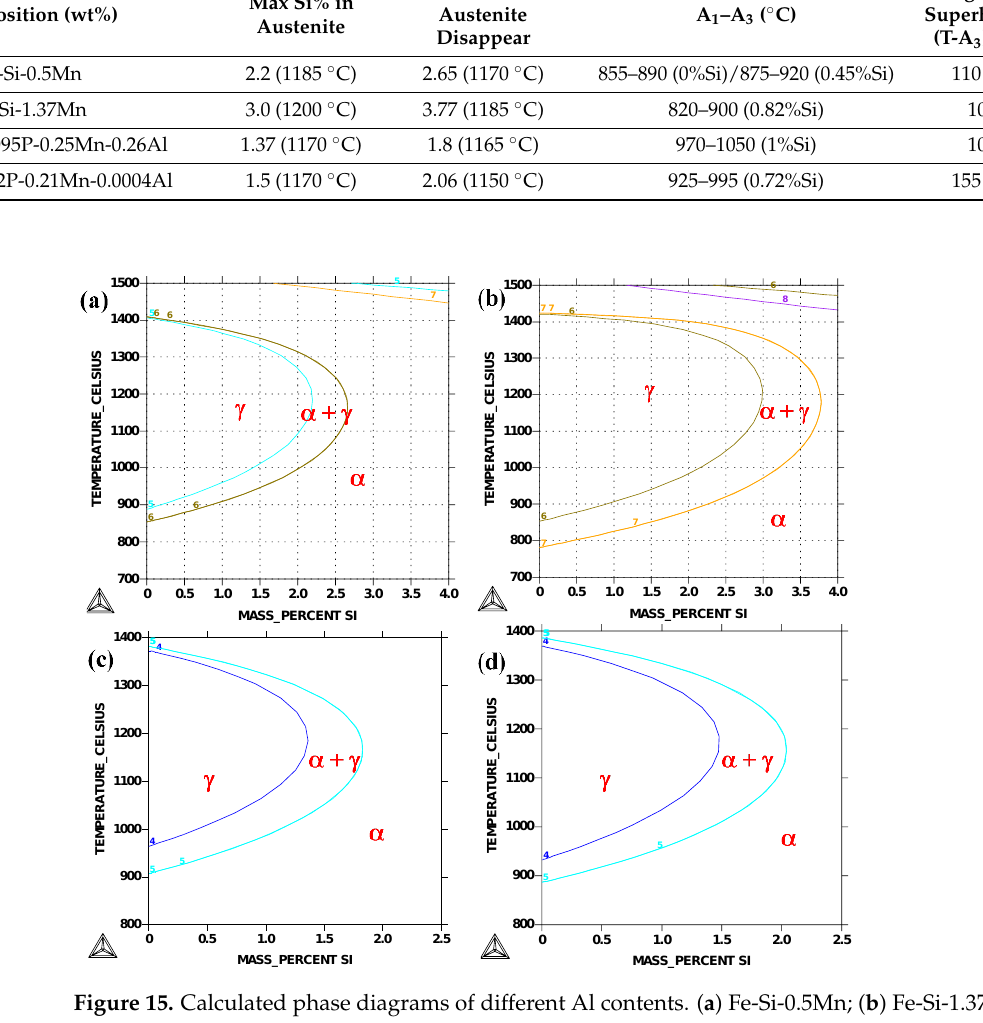
Figure 15. Calculated phase diagrams of different Al contents. ( a ) Fe-Si-0.5Mn; ( b ) Fe-Si-1.37Mn; ( c ) 1#; ( d ) 2#.